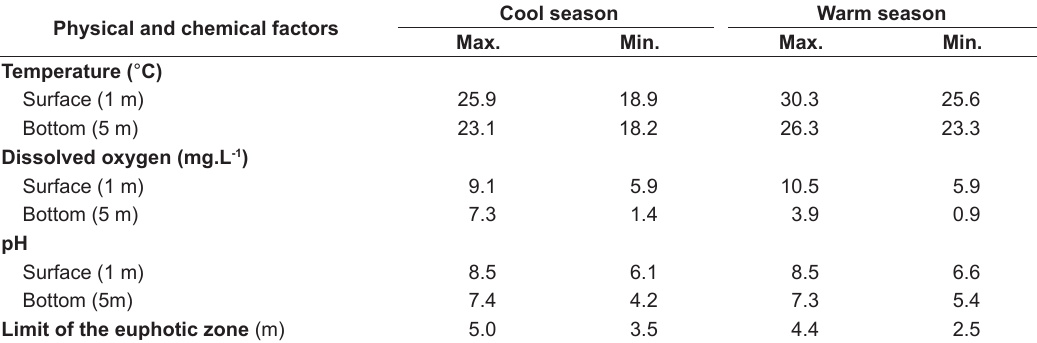
Table 1. Maximum and minimum values of temperature, dissolved oxygen and pH at surface and bottom of the lake, and the limit of the euphotic zone, in the cool and warm seasons. Physical and chemical factors